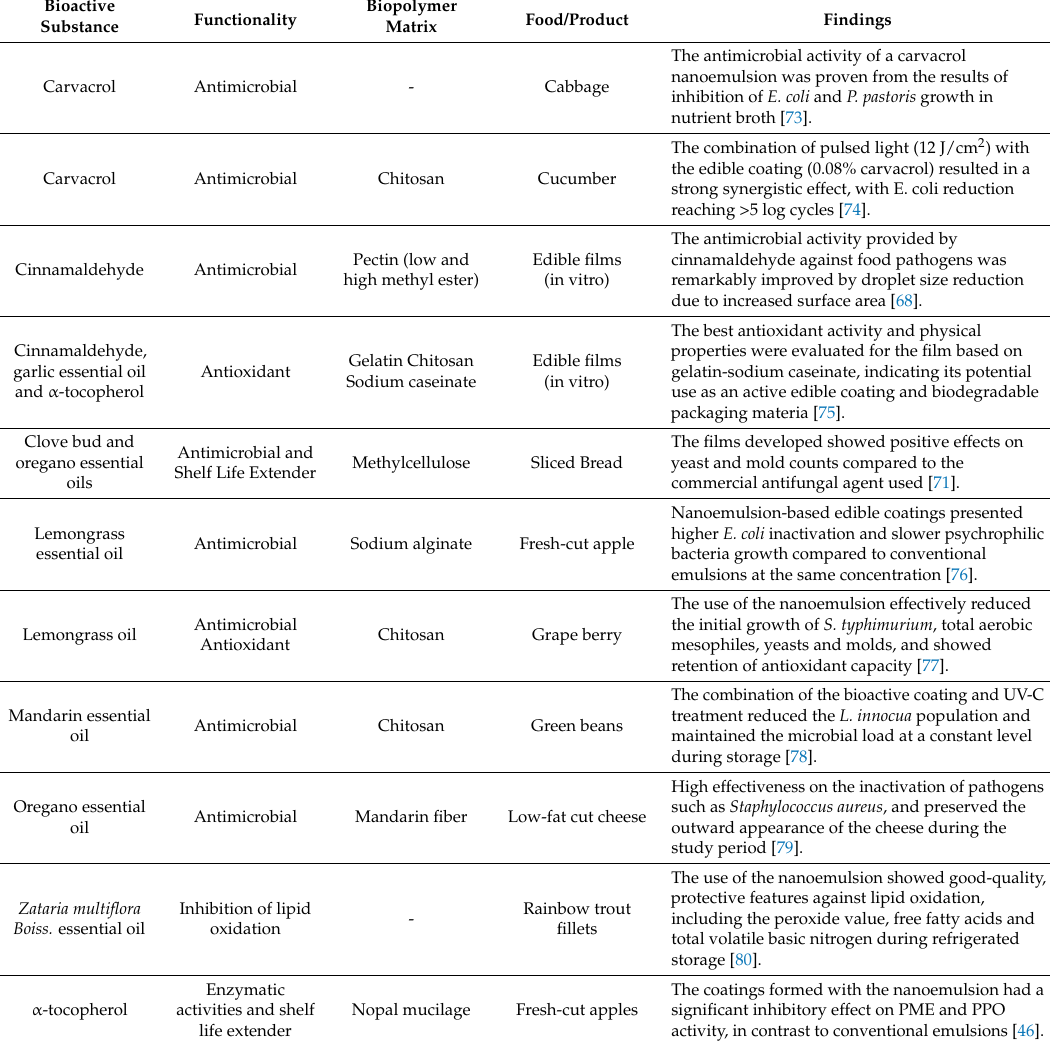
Table 1. Studies of the impact of nanoemulsions as edible coatings in different foods on shelf life, antioxidant capacity and antimicrobial and enzymatic